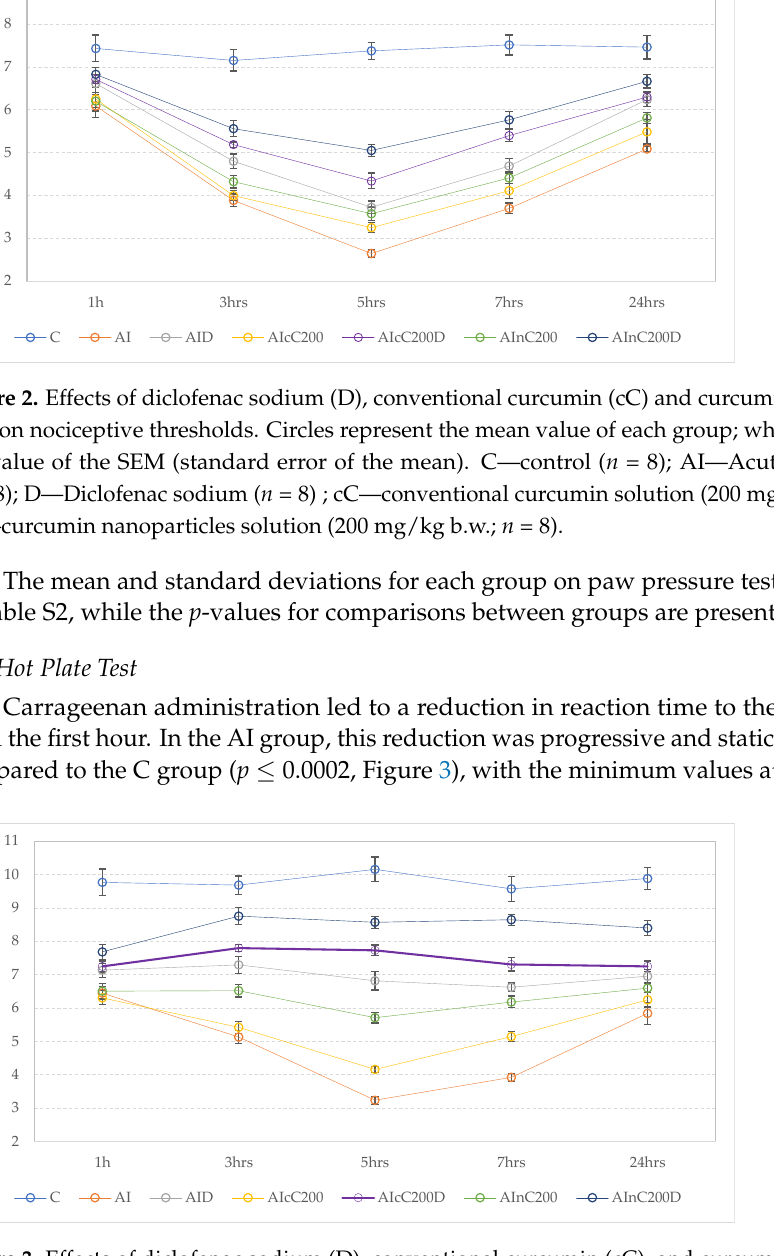
Figure 3. Effects of diclofenac sodium (D), conventional curcumin (cC), and curcumin nanoparticles (nC) on reactions time to the heat. Circles represent the mean value of each group; whiskers represent the value of the SEM (standard error of the mean). C—control ( n = 8); AI—Acute inflammation ( n = 8); D—Diclofenac sodium ( n = 8) ; cC—conventional curcumin solution (200 mg/kg b.w.; n = 8); nC—curcumin nanoparticles solution (200 mg/kg b.w.; n = 8).